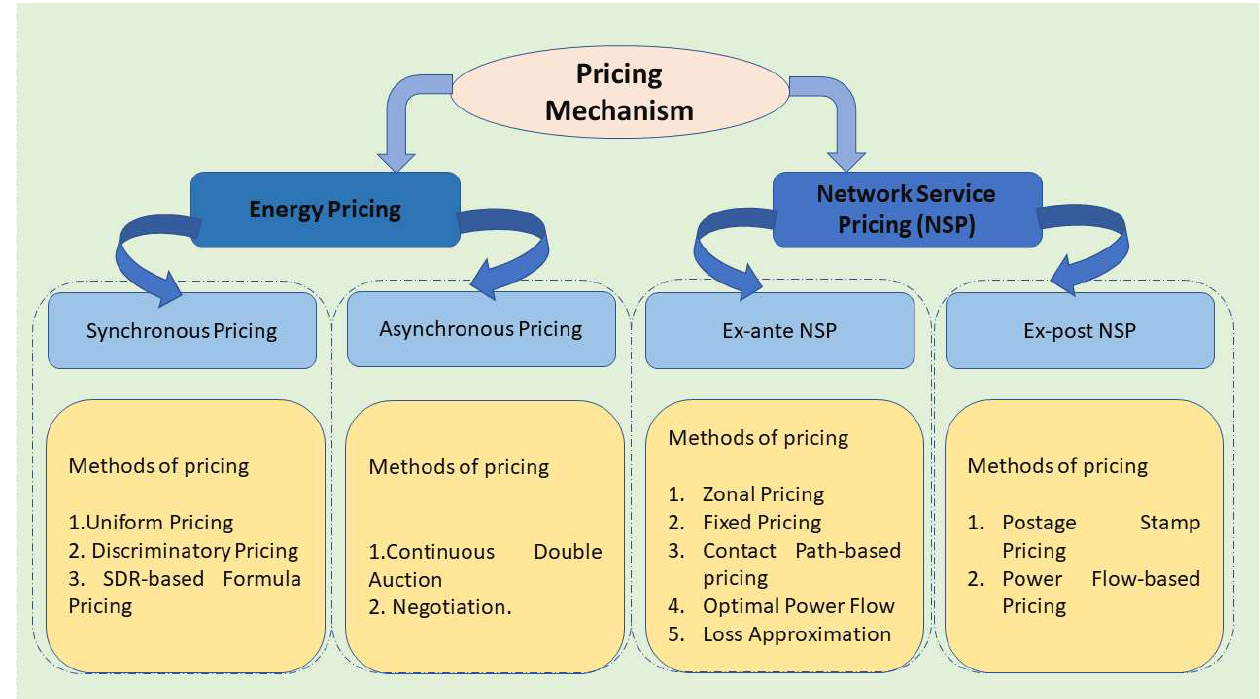
Figure 5. Classification of pricing mechanisms.